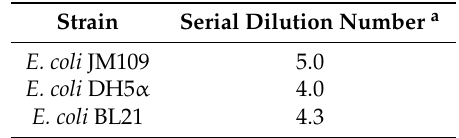
Table 3. Serial dilution number of the purified cecB2 against various E. coli